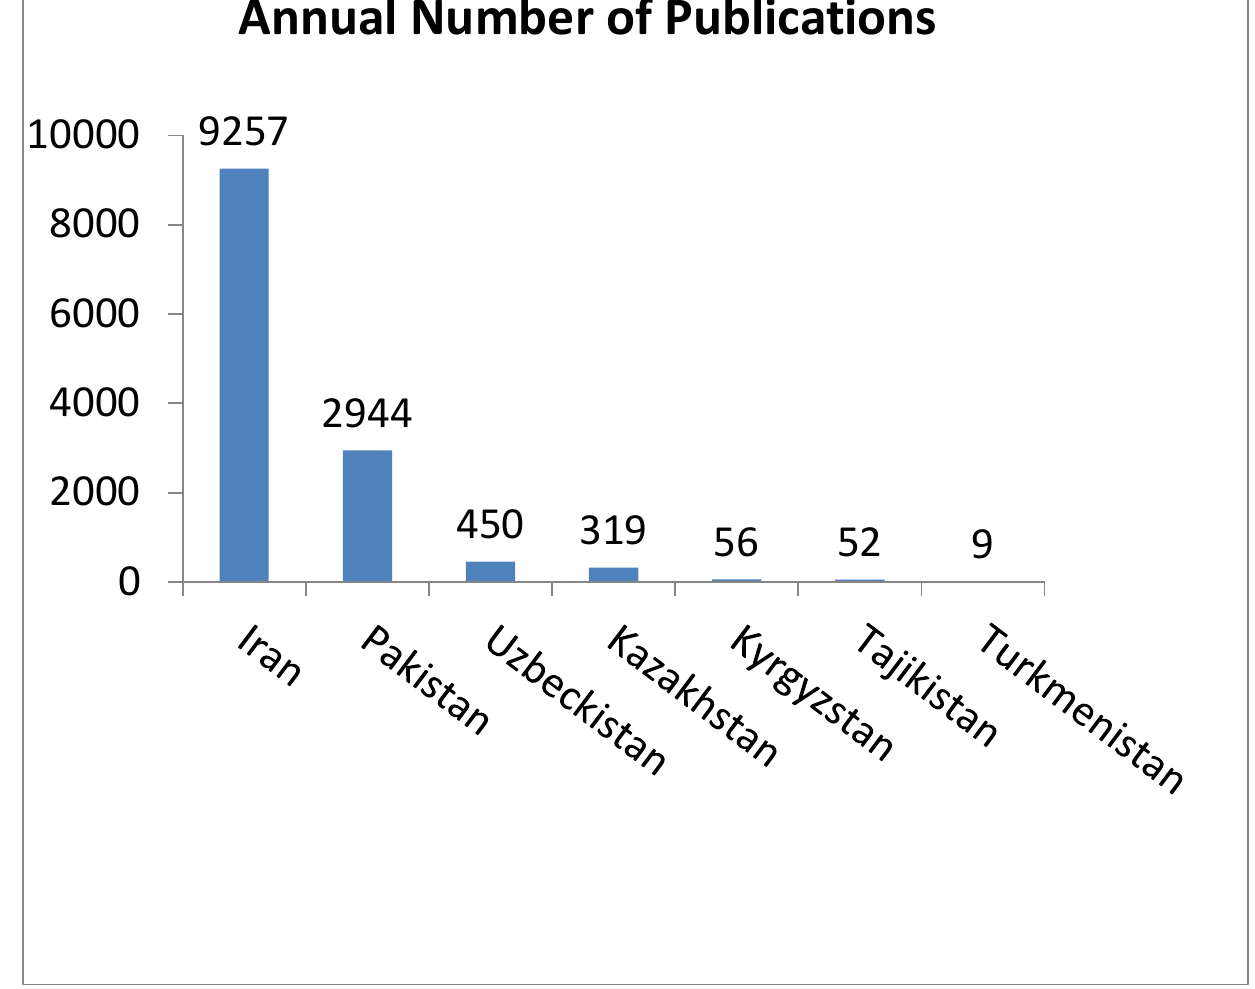
Figure 2: Comparison of number of publications from countries adjacent to Central Asia and the countries of Central Asia.